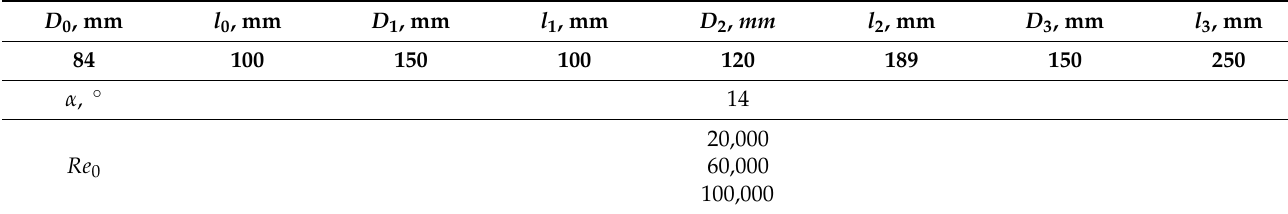
Table 2. Geometrical and regime characteristics of the compound